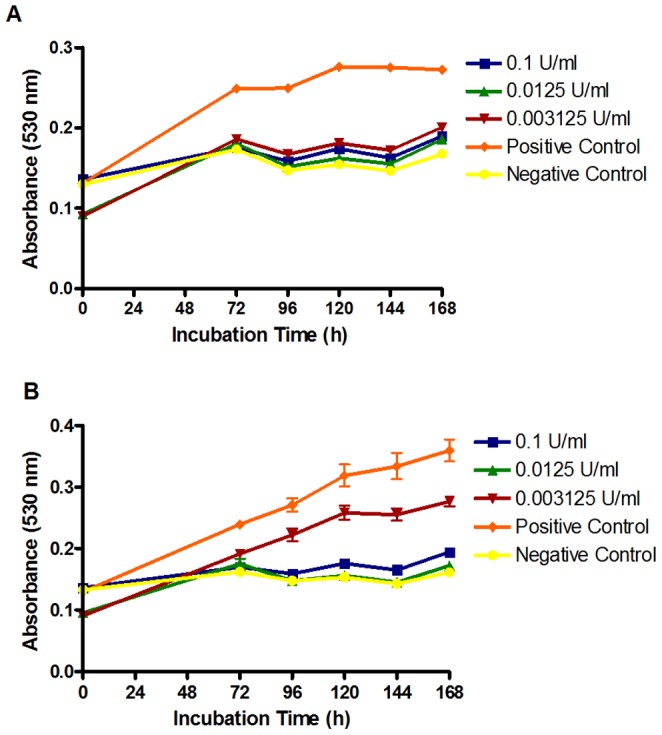
Determination of the amount of exogenous β-glucosidase required to exert an antifungal effect from esculin (3402.8 µg/ml).The negative control containing 348.36 µg/ml esculetin + 0.005 U/ml β-glucosidase demonstrated total kill for both strains. The positive control contains 0.005 U/ml β-glucosidase but no esculin and resulted in no growth inhibition. β-glucosidase at all concentrations tested demonstrated no antifungal activity. All results are representative of triplicate samples from triplicate experiments. Error bars represent the standard deviation of the mean.